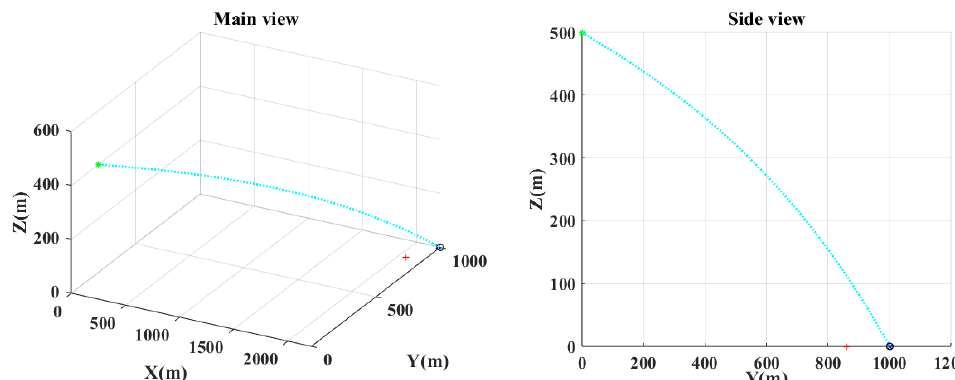
Figure 8. The ballistic of GD in case 1.